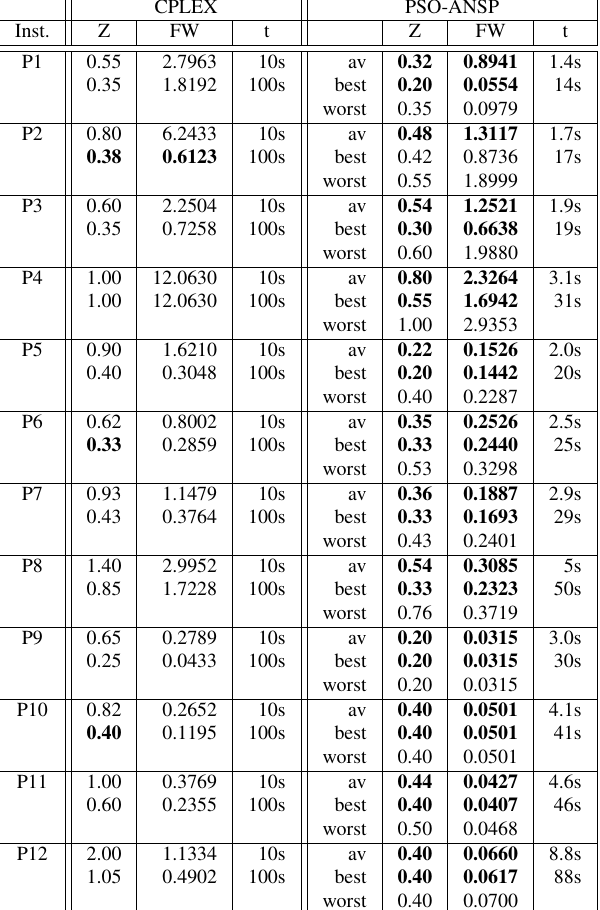
Table 9. Result comparison between the ILOG CPLEX solver (by using the ILP model) and the PSO-ANSP algorithm on the twelve instances. CPLEX PSO-ANSP